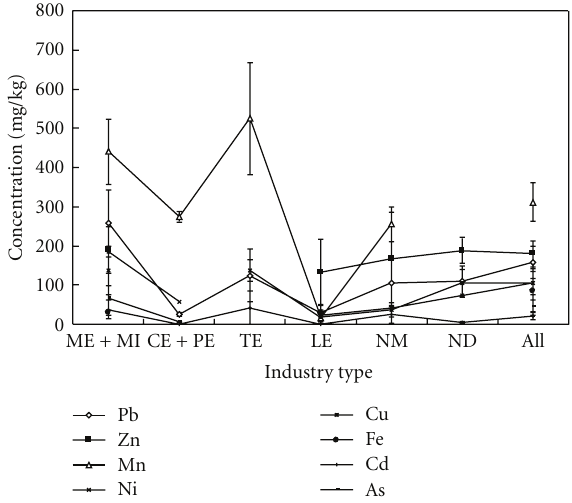
Figure 2: Comparison of soil metal levels a ff ected by di ff erent industry